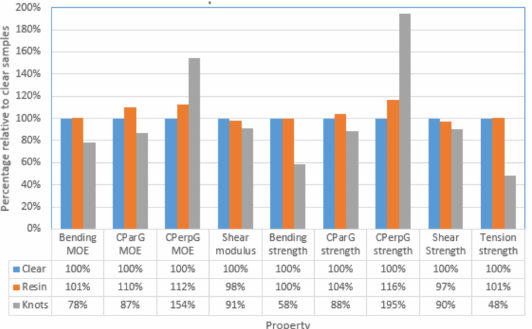
Figure 32. Summary of structural performance of resin and knot samples relative to clear.